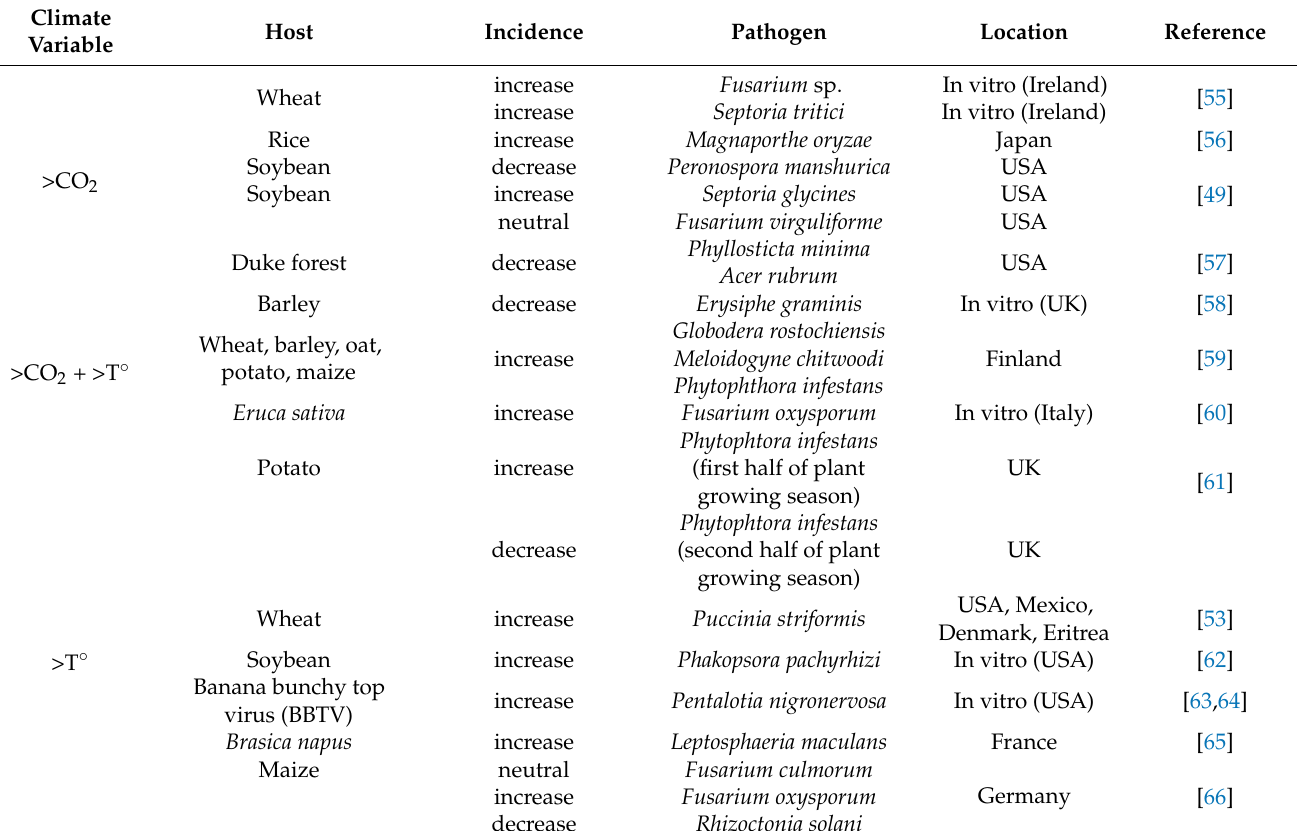
Table 1. Effect of climate change and plant disease